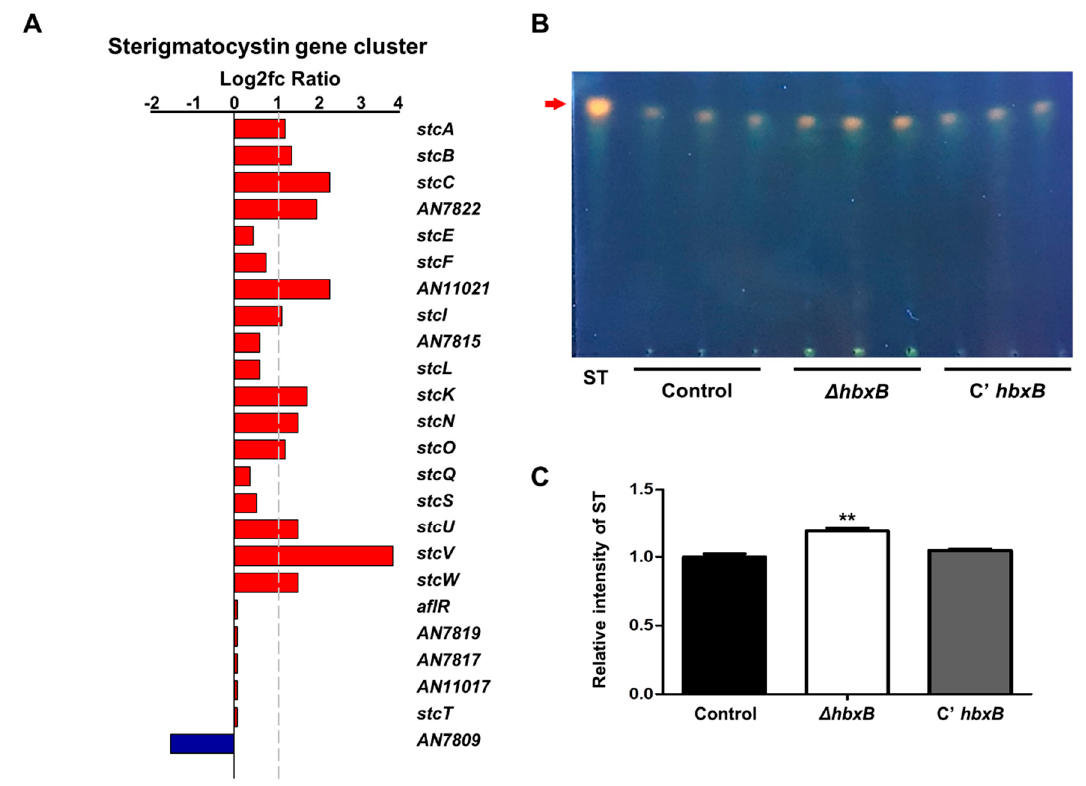
Figure 4. Role of hbxB for sterigmatocystin production in A. nidulans conidia. ( A ) mRNA expression of genes associated with the sterigmatocystin gene in hbxB deletion mutant conidia was verified by RNA-sequencing (RNA-seq) analysis. ( B ) Thin-layer chromatography (TLC) images of sterigmatocystin from control (TNJ36), Δ hbxB (TSH1.1), and C’ hbxB (TSH7.1) strain conidia. ( C ) Relative intensity of sterigmatocystin in ( B ) using ImageJ software. ** p < 0.01, differences between control and Δ hbxB conidia.